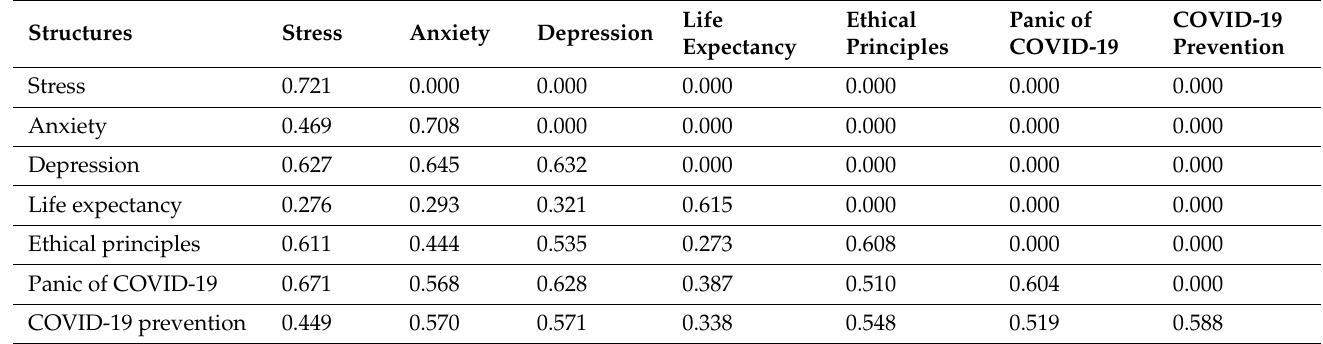
Table 2. The divergent validity matrix of the research model by the Fornell–Larker method.